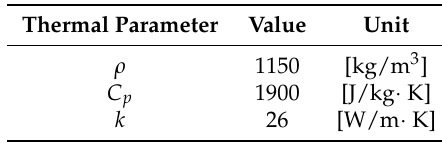
Table 3. Thermo-physical properties of the studied Nickel Manganese Cobalt(NMC)/Graphite type of battery cell.